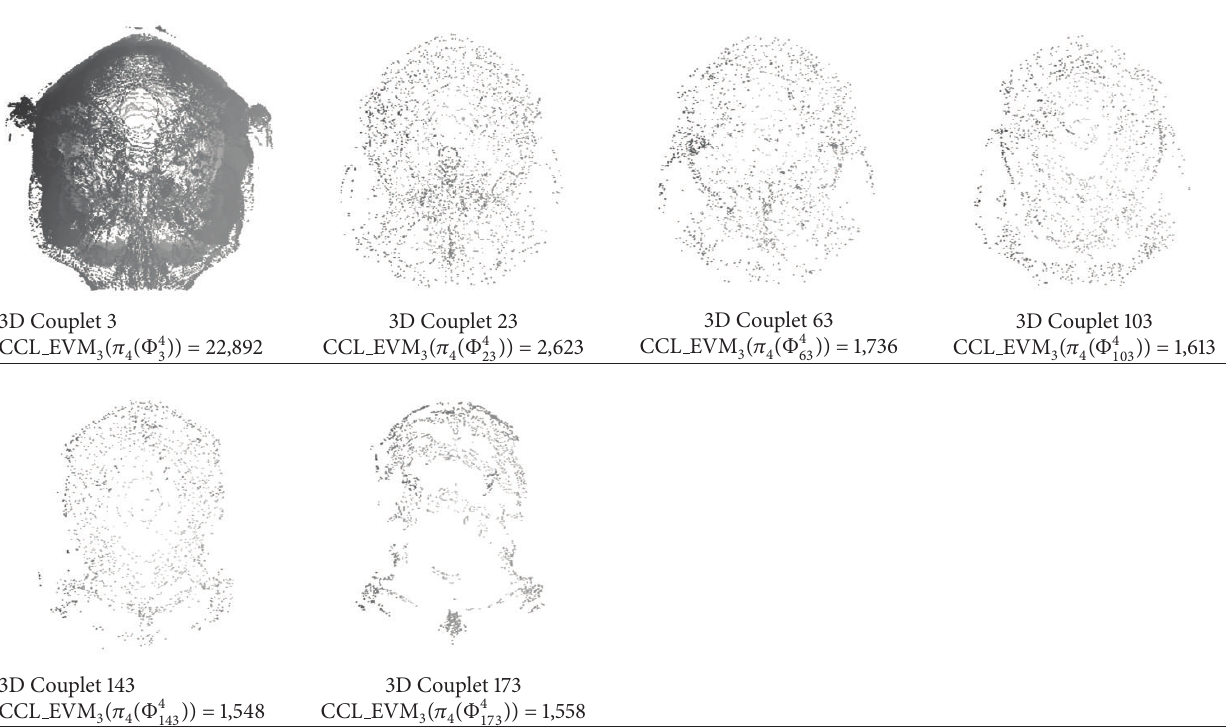
Table 4: Some 3D Couplets, perpendicular to color axis, extracted from the 4D-EVM associated to dataset CT-Monkey .